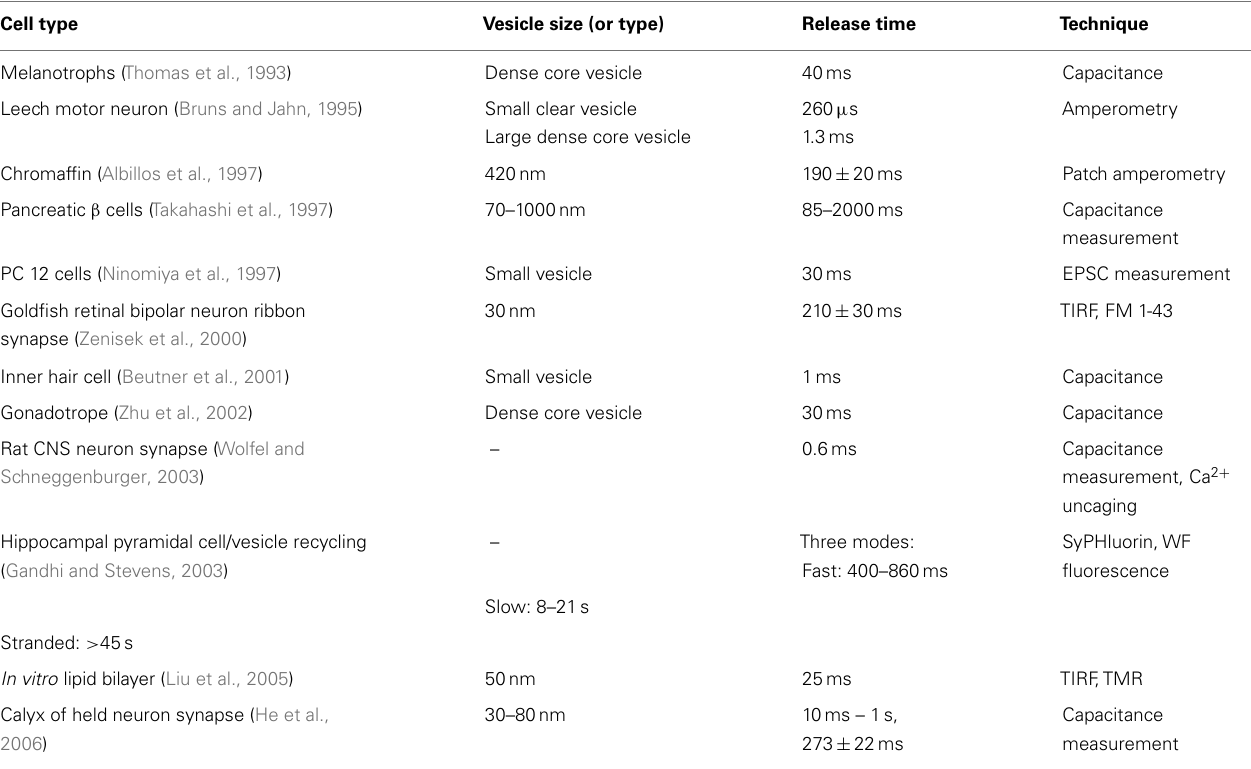
TableA1 |Timescales of